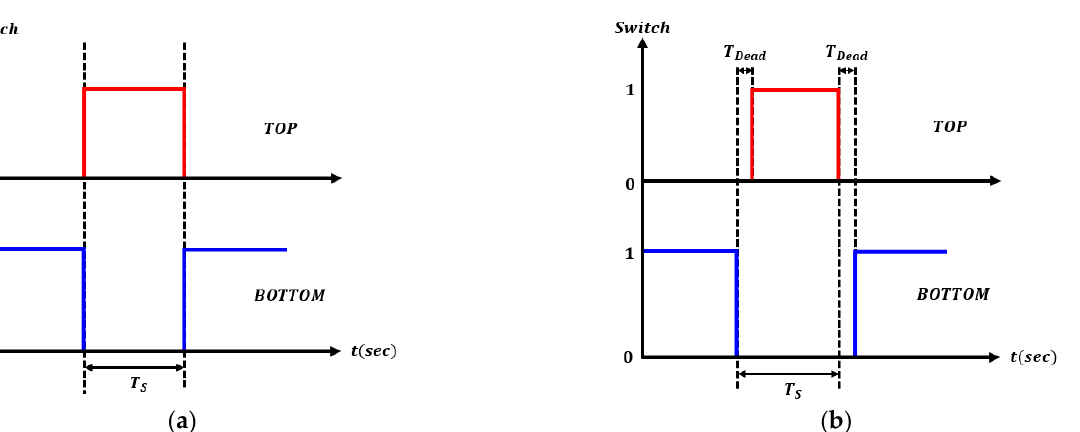
Figure 6. ( a ) ON/OFF signal of TOP/BOTTOM power switch element in an ideal case without dead time. ( b ) ON/OFF signal of TOP/BOTTOM power switch element with dead time.